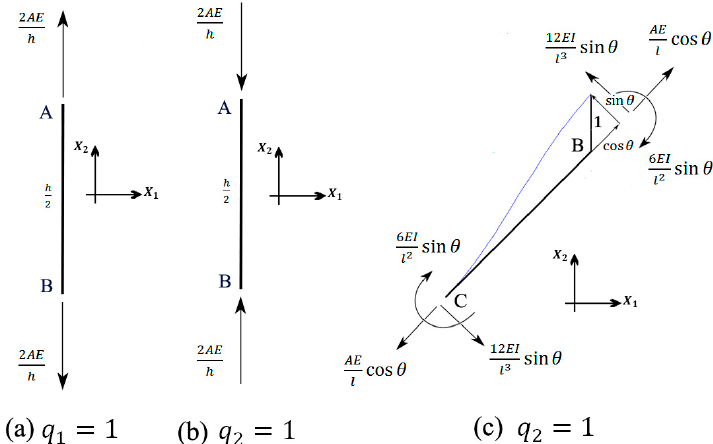
Figure 6. Free-body diagrams of struts ( a ) AB in deformation (cid:1869) (cid:2869) = 1 ; ( b ) AB in deformation (cid:1869) (cid:2870) = 1 ; and ( c ) BC in deformation q 2 “ 1 of the hexagonal honeycomb unit